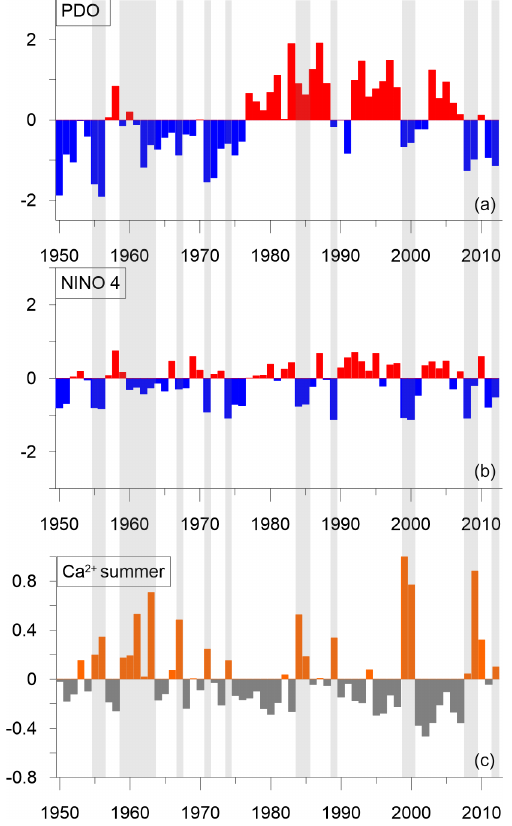
Figure 12. PDO (a) , Niño 4 indices (December–June aver- age) (b) , and normalized Ca 2 + record (c) . Grey shading indi- cates years when high dust concentrations coincided with negative Niño 4 phases.